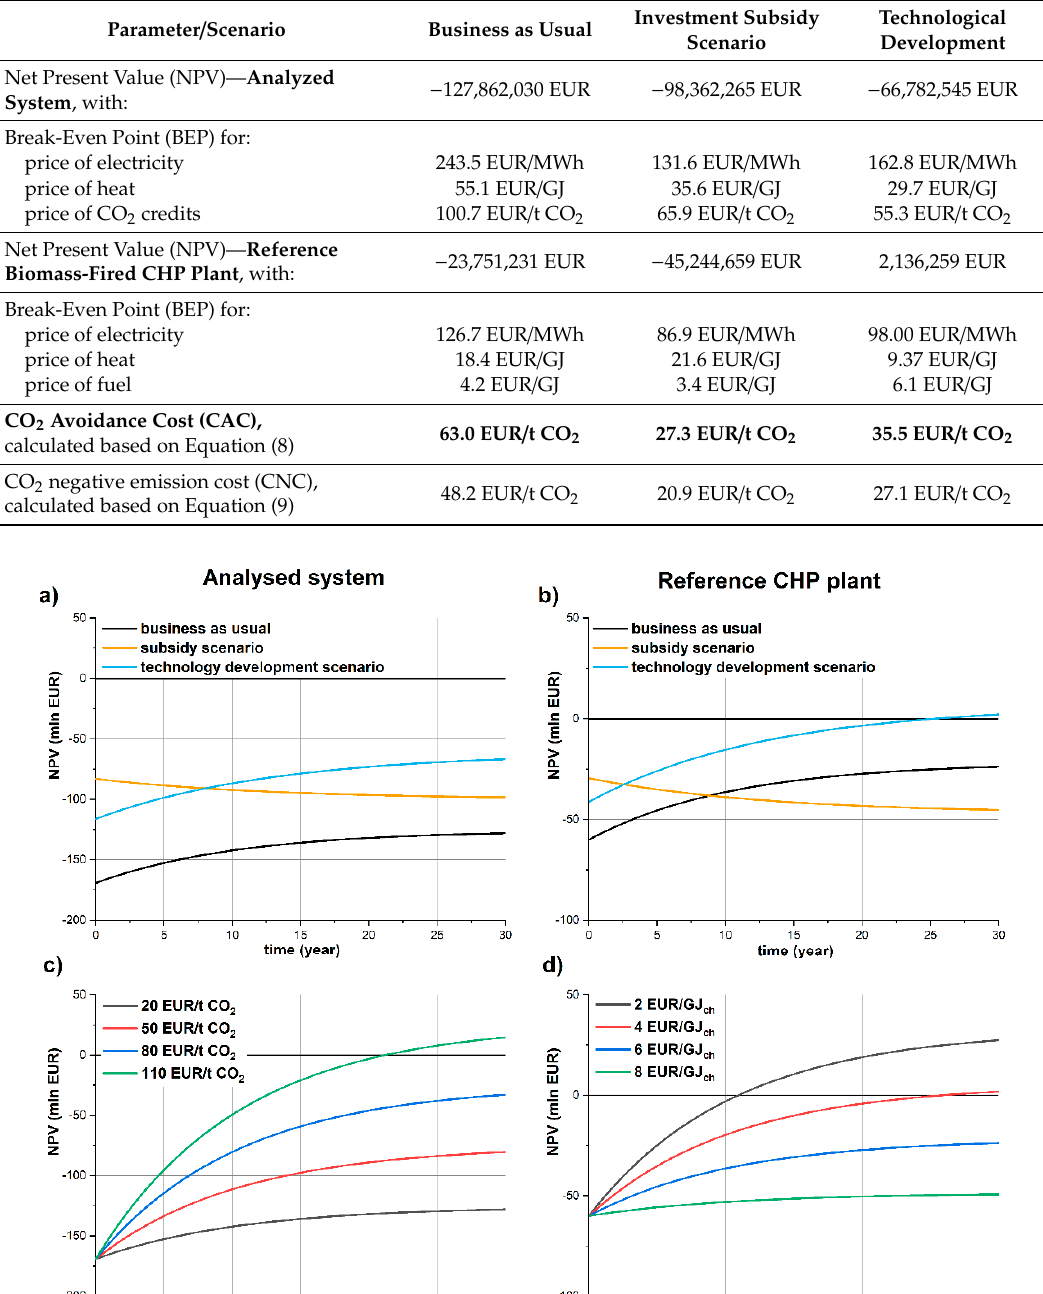
Table 7. Summary of the economic assessment.